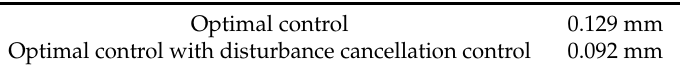
Table 5. Standard deviation of displacement.